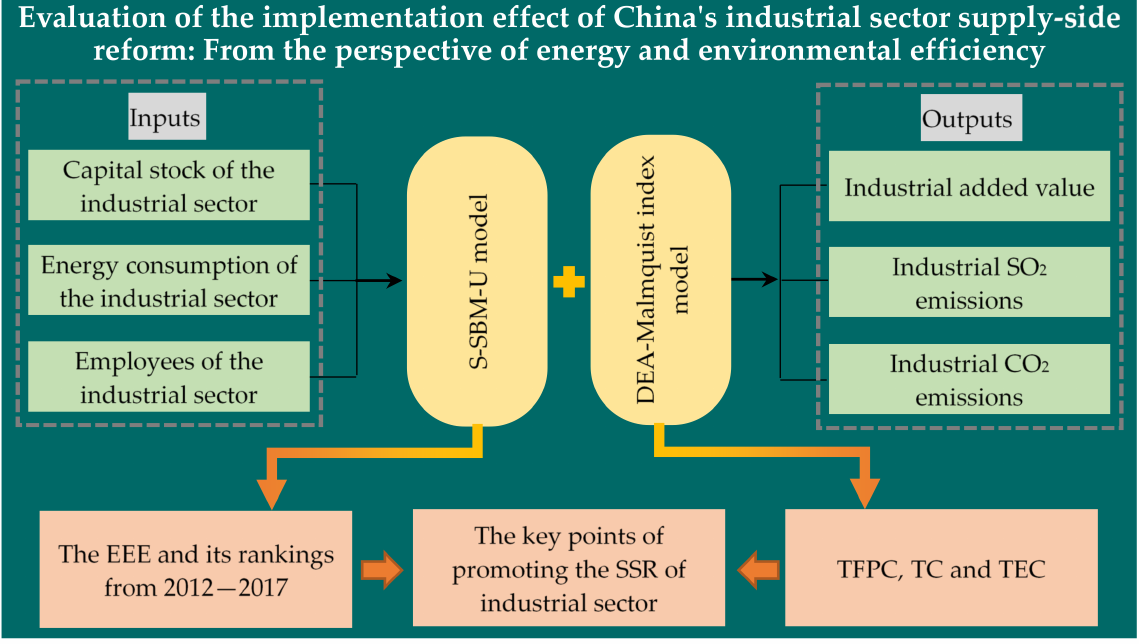
Figure 2. The research